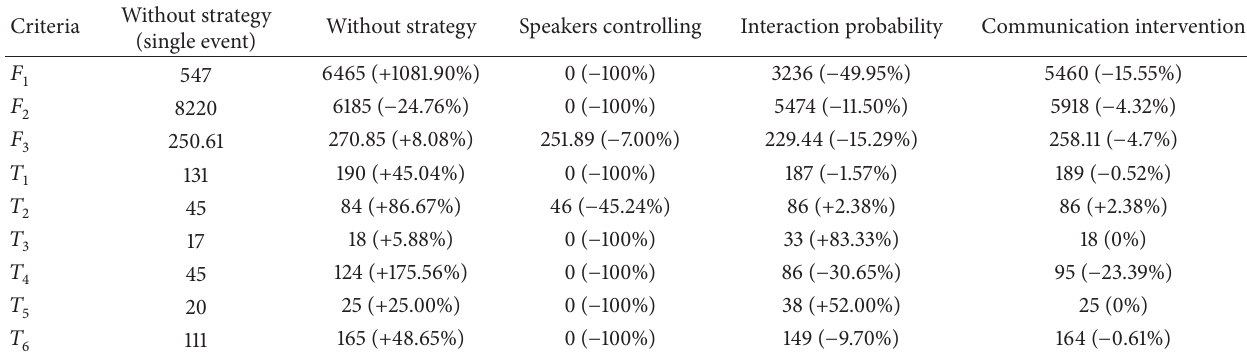
Table 3: Strategy effectiveness results of successive events.